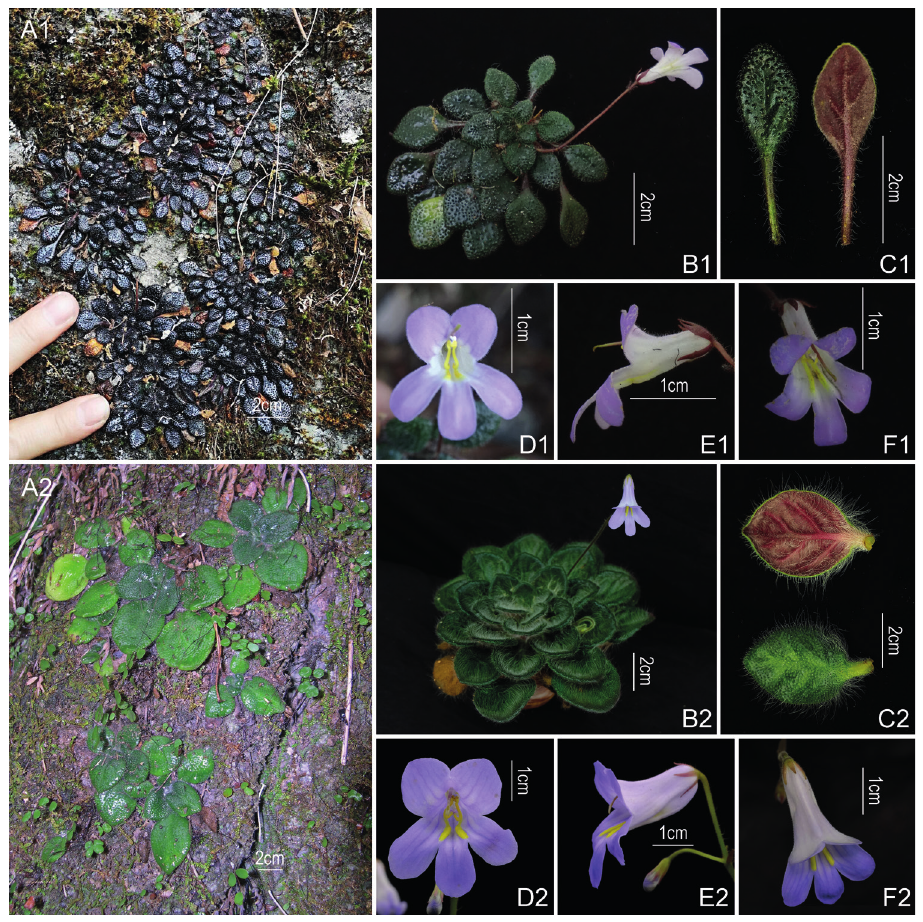
Figure 2. Morphological comparison of Primulina nana sp. nov. (1) with P. yangshuoensis (2) A habitat B habit C leaf blades D front view of flowers E lateral view of flowers F top view of flowers. A1 and D1 photographed by Wei-Chuen Chou; B1–C1, E1–F1, C2 photographs by Chi Xiong; A2–B2 and D2–F2 photographed by Fang